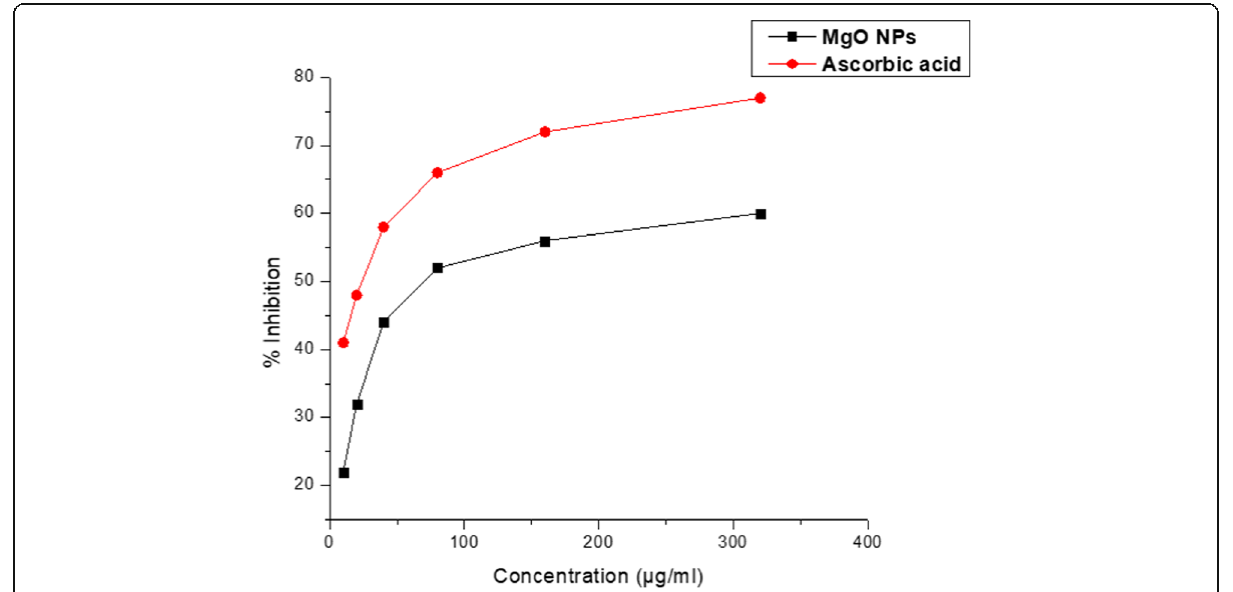
Fig. 7 DPPH radical scavenging activity of MgO nanoparticles synthesized with Pterocarpus marsupium heartwood aqueous extract